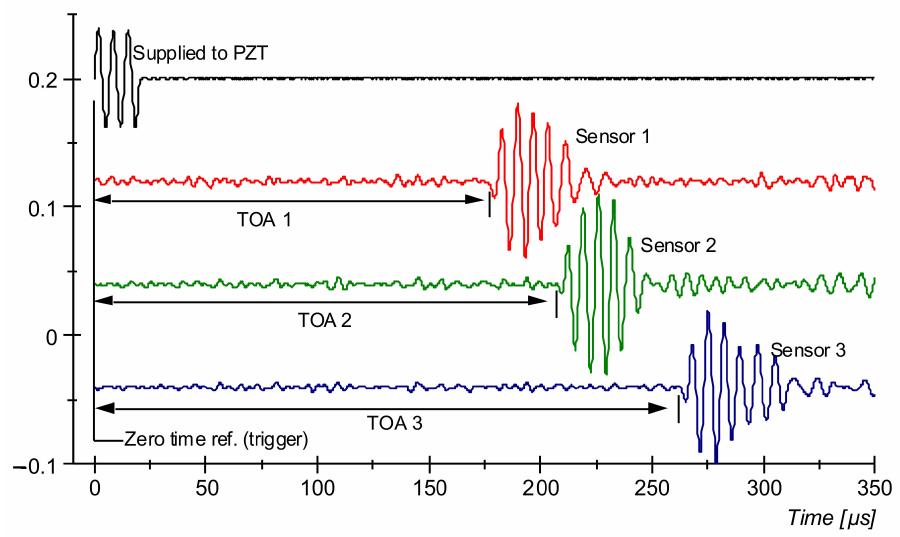
Figure 8. Typical AE signal detected by the system using three sensors and the TOA related each of